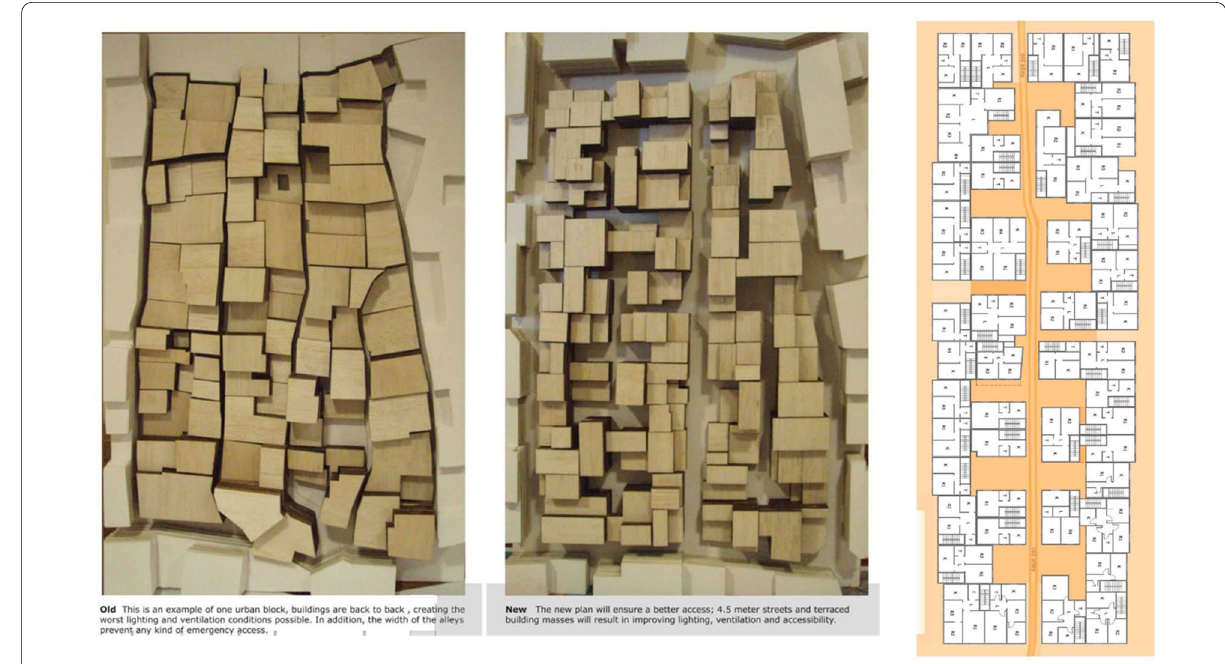
Fig. 5 Nahr El Bared Refugee Camp (Source: Author